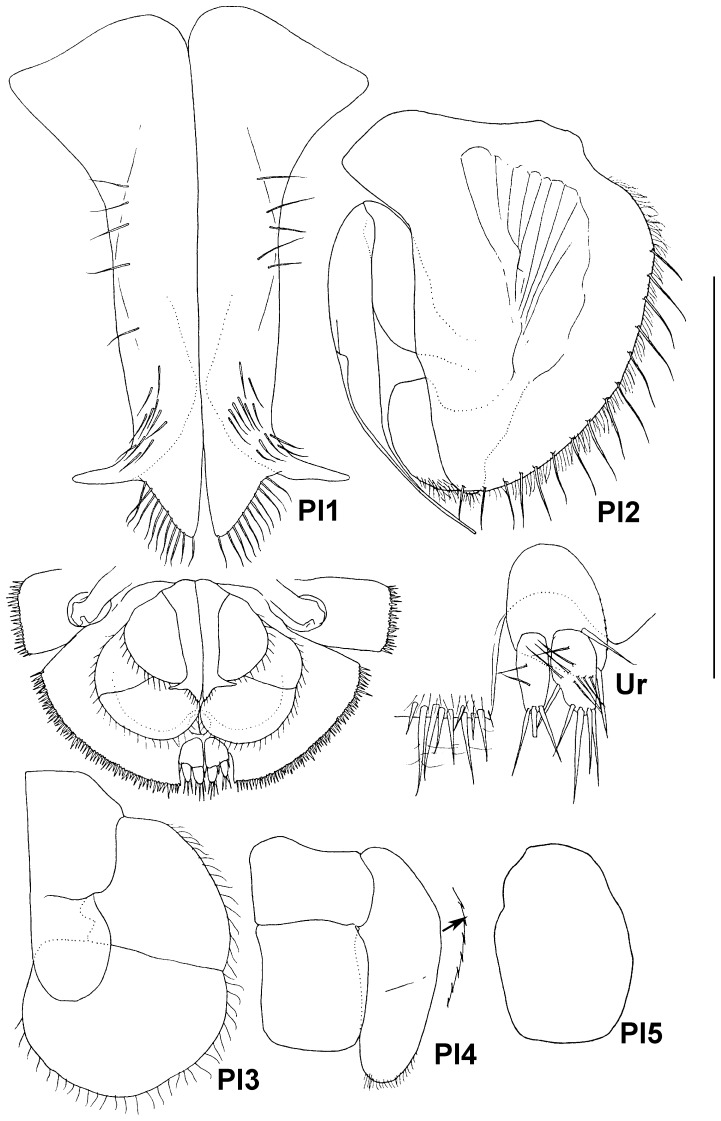
Paratype ZMH K-44090, male, pleotelson, ventral view, pleopods 1–5, uropod, scale – 0.5 mm for pleopods 1 and 2 and uropod and 1 mm for pleopods 3–5.